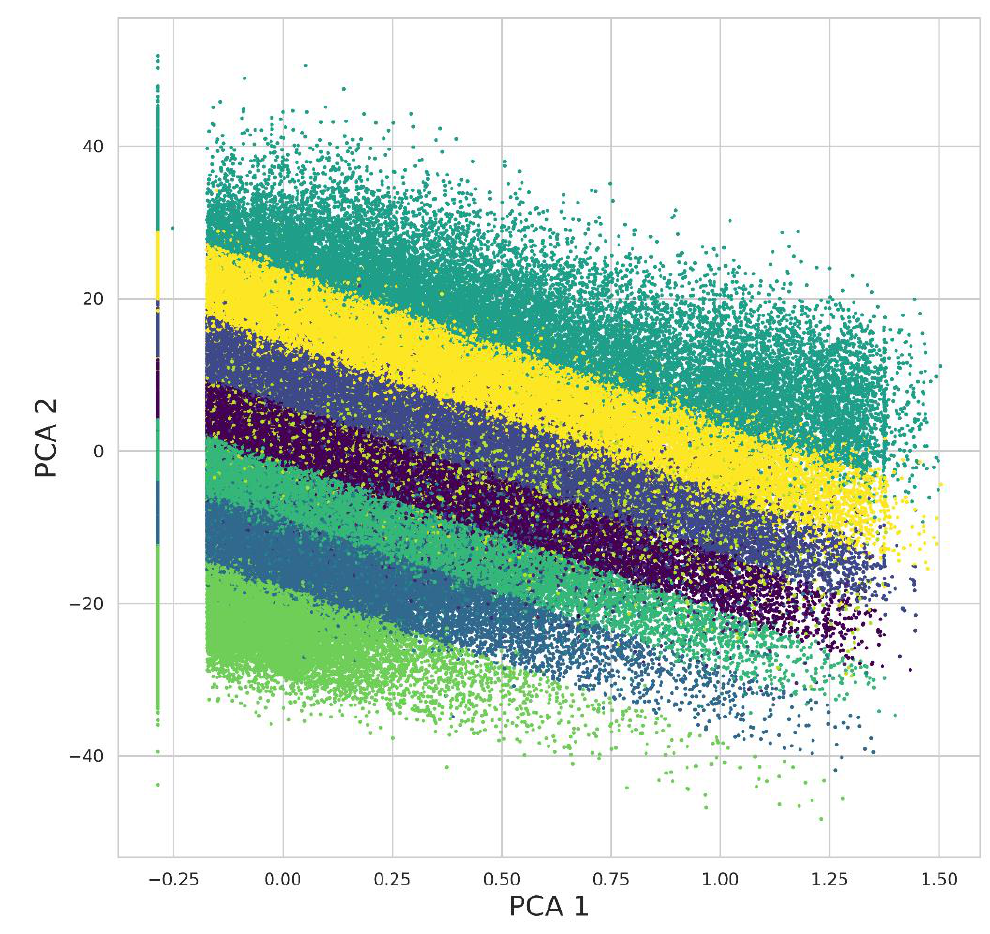
Figure 4. Network metric clustering results (PCA) colored by cluster. Table 4. Clustering result legend including color, index, and SINR/RSRP profile quality class.